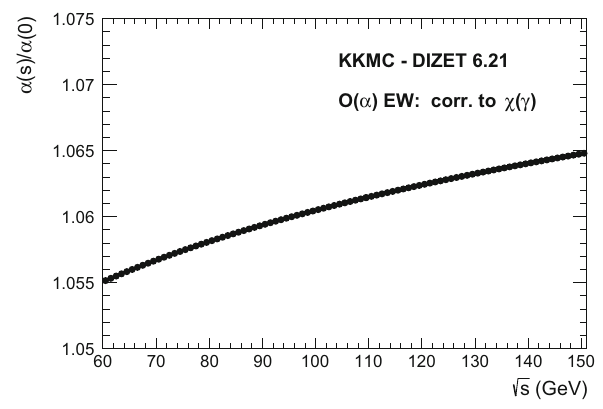
Fig. 2 The vacuum polarization ( α( s )/α( 0 ) ) correction of γ propaga- tor, Eq.